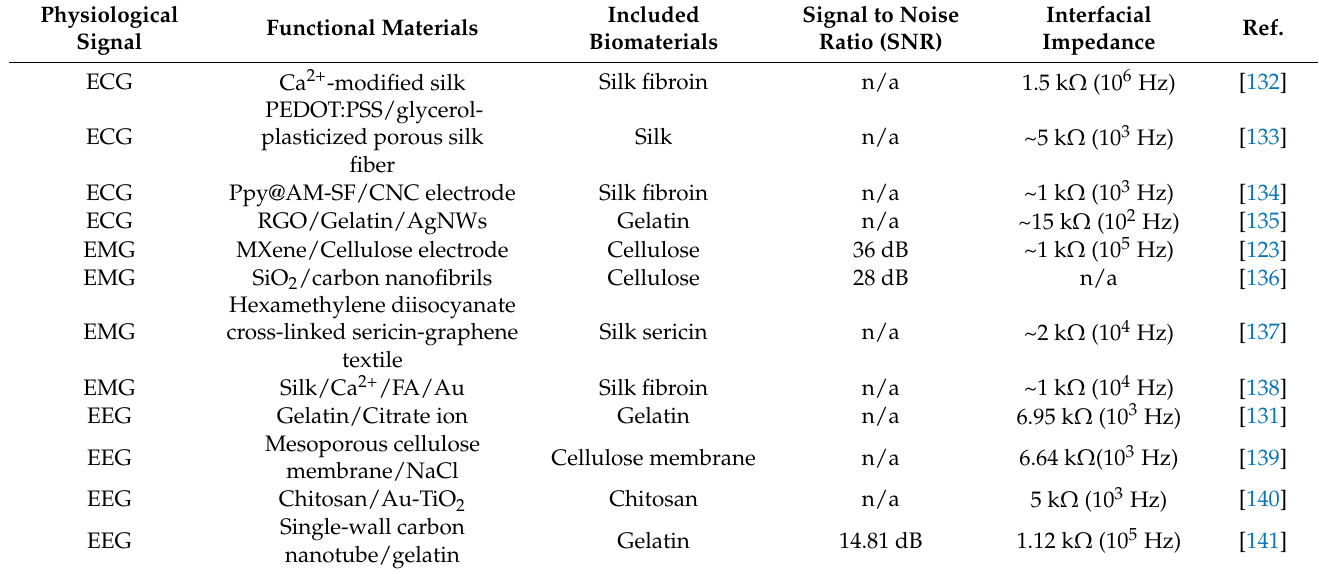
Table 1. Biomaterials used in electrophysiological recording and corresponding